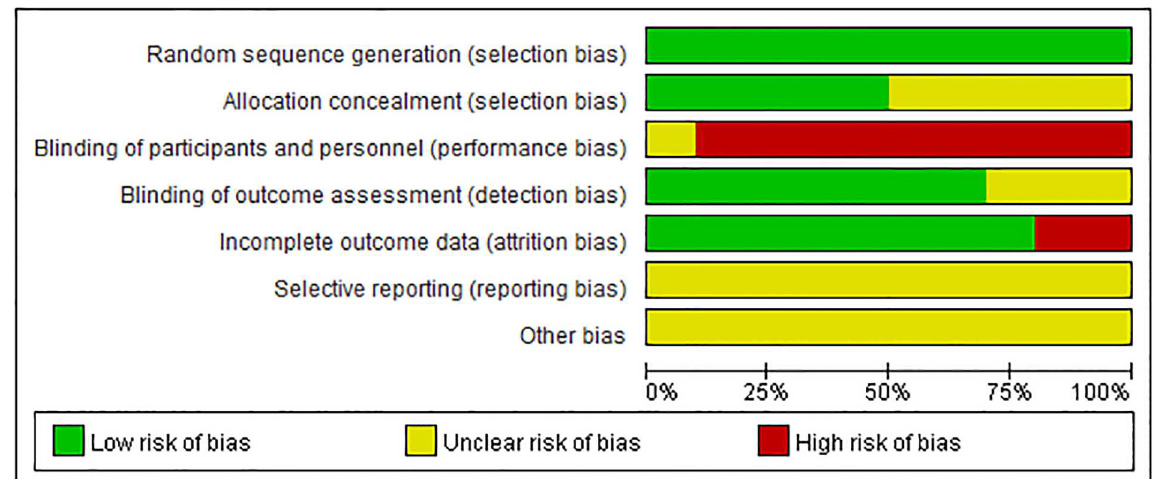
Fig 2. Risk of bias graph: Review authors’ judgements about each risk of bias item, presented as a percentage, across all included studies.